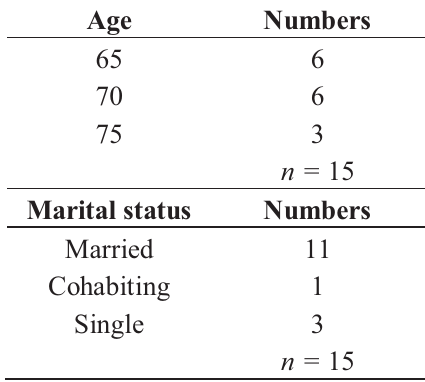
Table 1. Description of the study group with regard to age and marital